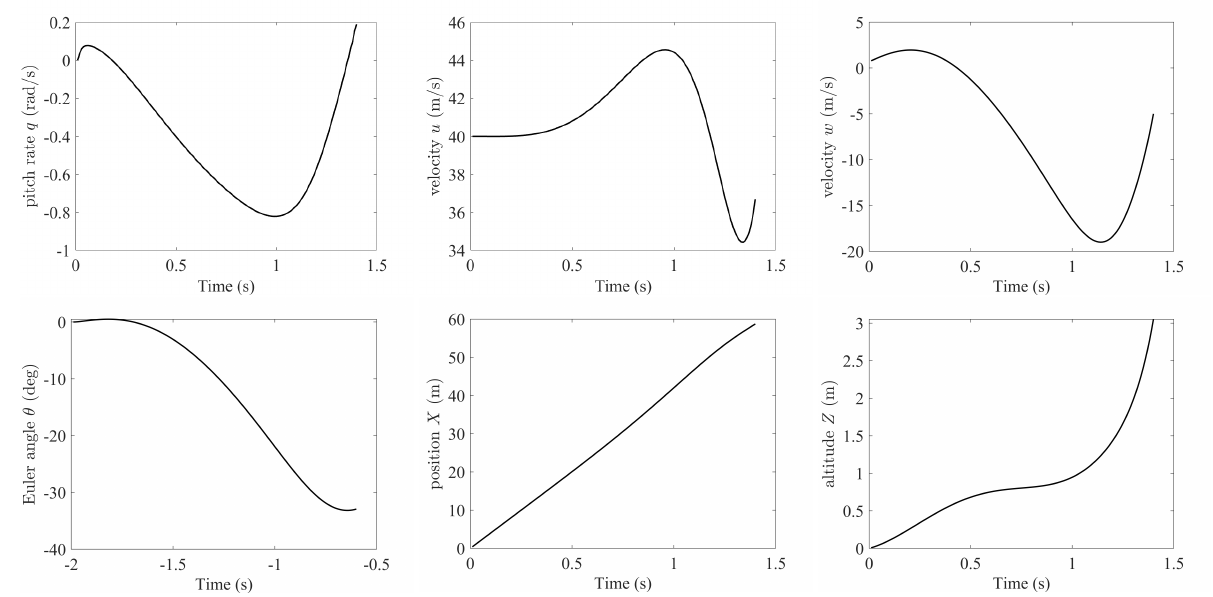
Figure 17. Time history of kinematic